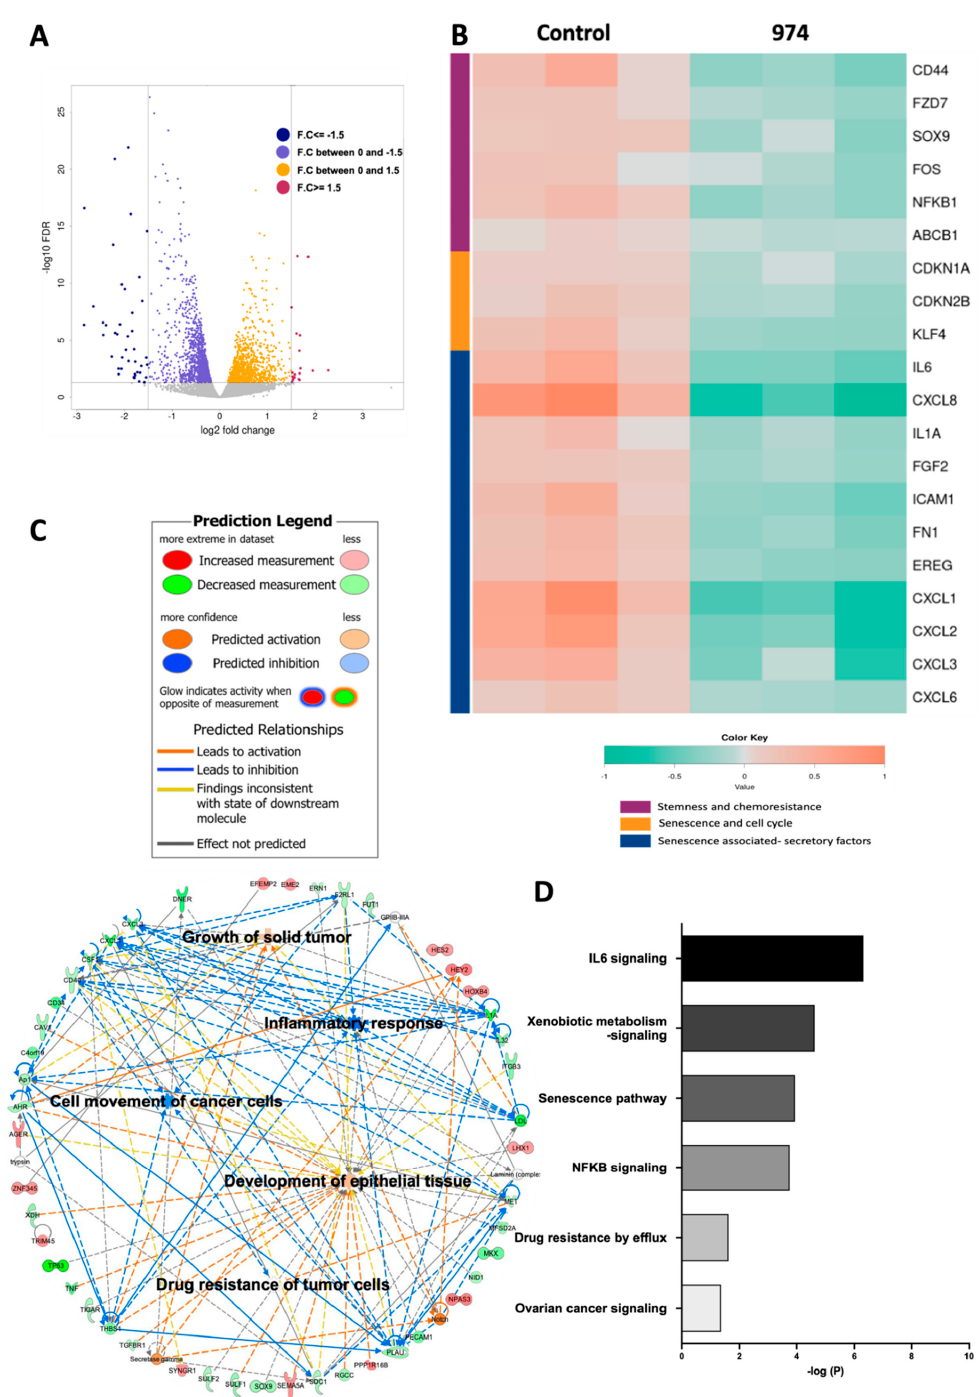
Figure 4. ALDH1A1 inhibition suppresses pathways involved in chemoresistance and stemness. RNA-seq was performed on OVCAR3 cells treated with compound 974 (5 µM for 48 h) or DMSO (n = 3). ( A ) Volcano plot of genes up and downregulated by ALDH1A1 inhibition. ( B ) Heatmap of selected genes significantly downregulated by compound 974 (FDR < 0.05). ( C ) Networks of biological processes constructed using significantly altered genes (FDR < 0.05) between OVCAR3 cells treated with 974 or DMSO. ( D ) Canonical pathways related to stemness and chemoresistance identified by the Ingenuity Pathway Analysis (IPA) using genes significantly altered by 974 treatment (FDR < 0.05, fold change >